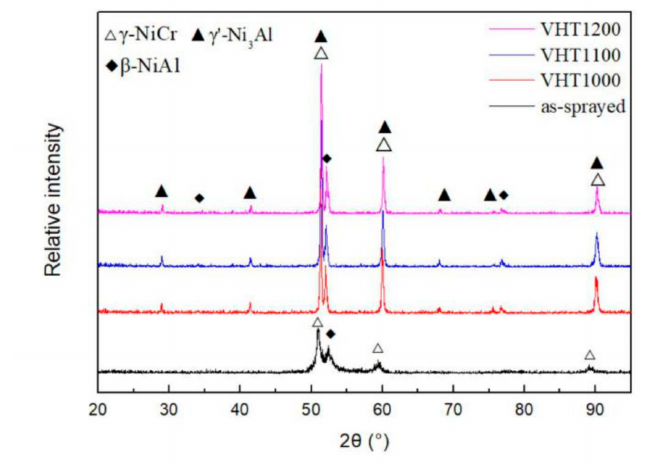
Figure 9. XRD results of the as-sprayed and heat-treated coatings.